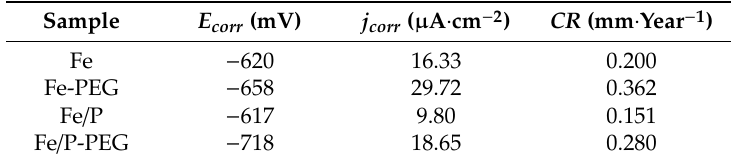
Table 4. Electrochemical data and corrosion rate ( CR ) of iron-based foams (Fe, Fe-PEG, Fe / P, and Fe / P-PEG) in Hanks’ solution.